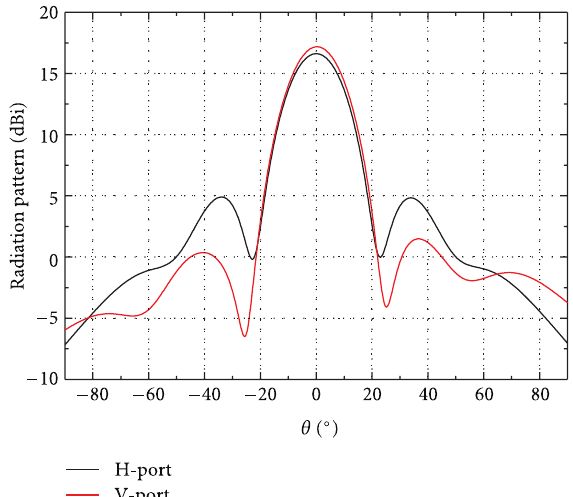
Figure 5: The radiation patterns of the dual-polarized microstrip antenna array at the center frequency.